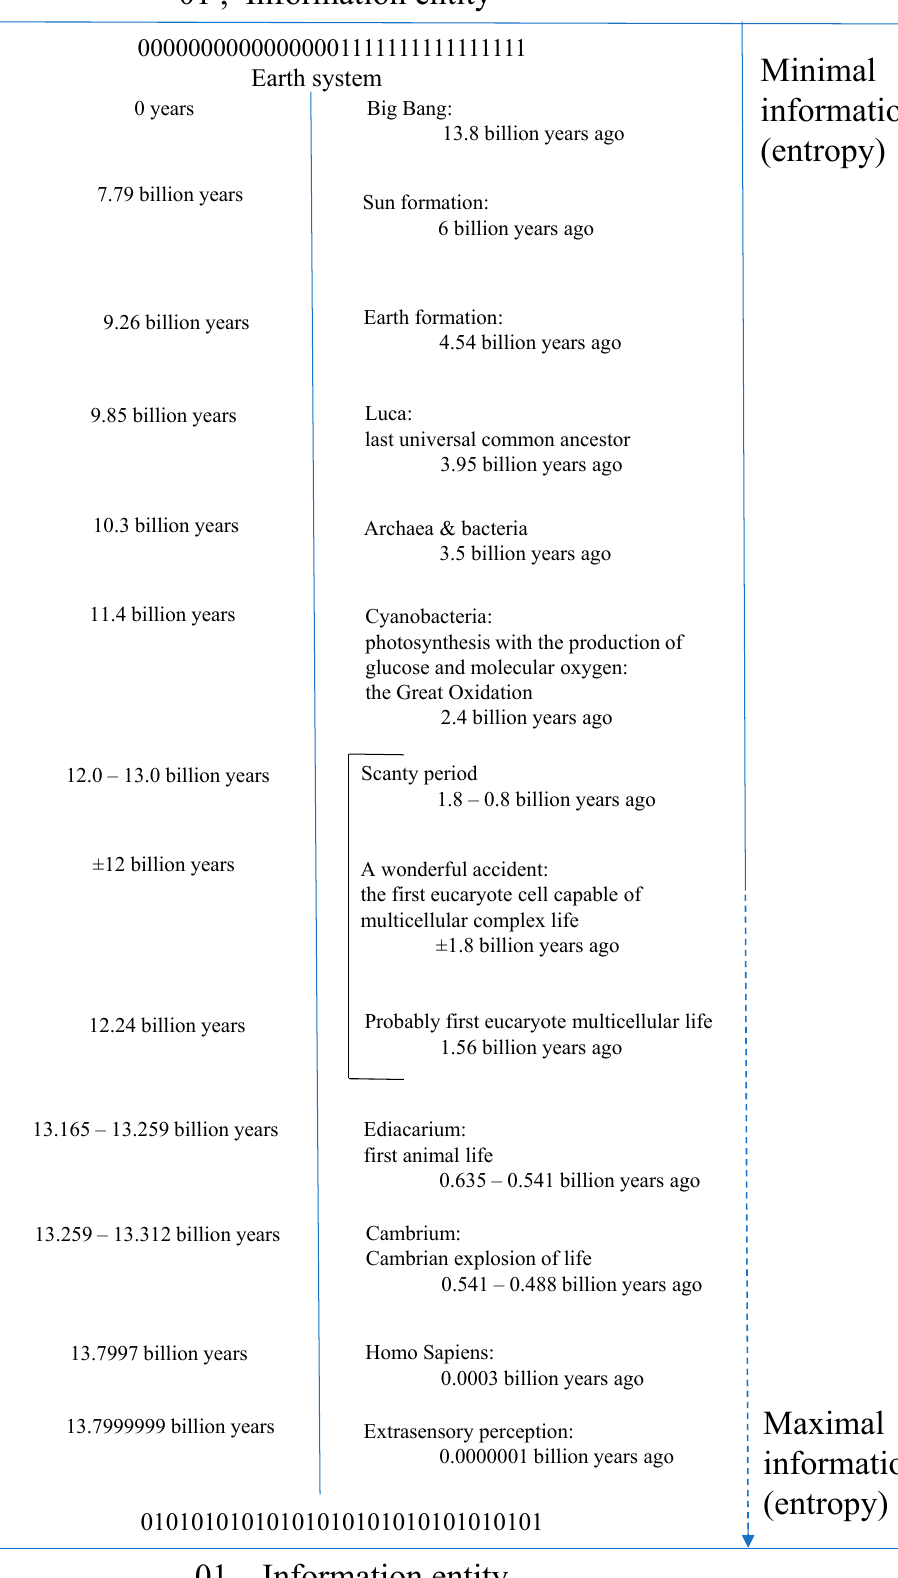
Figure A2. The appearance of a world–the Earth system. (Graphics Simon